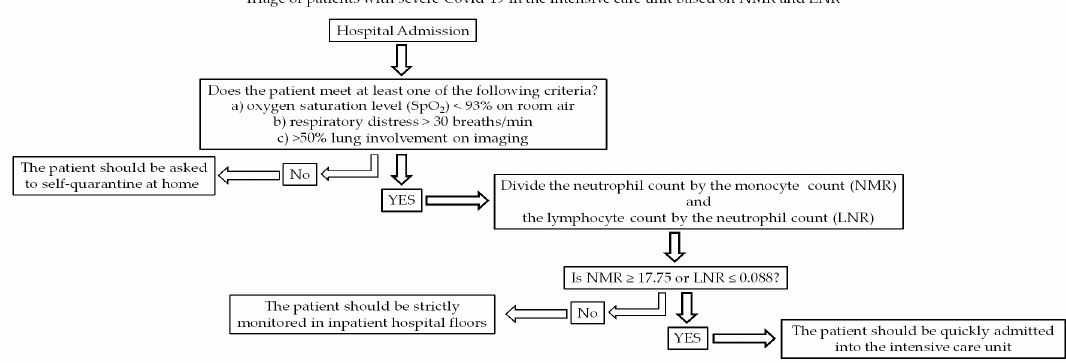
Figure 5. Proposal of triage based on NMR and LNR for patients seriously ill with Covid-19 that meet hospitalization criteria. At hospital admission, the neutrophil count should be divided by the monocyte count (NMR) and the lymphocyte count by the neutrophil count (LNR). If NMR ≥ 17.75 or LNR ≤ 0.088, the patient should be quickly admitted into the intensive care unit.